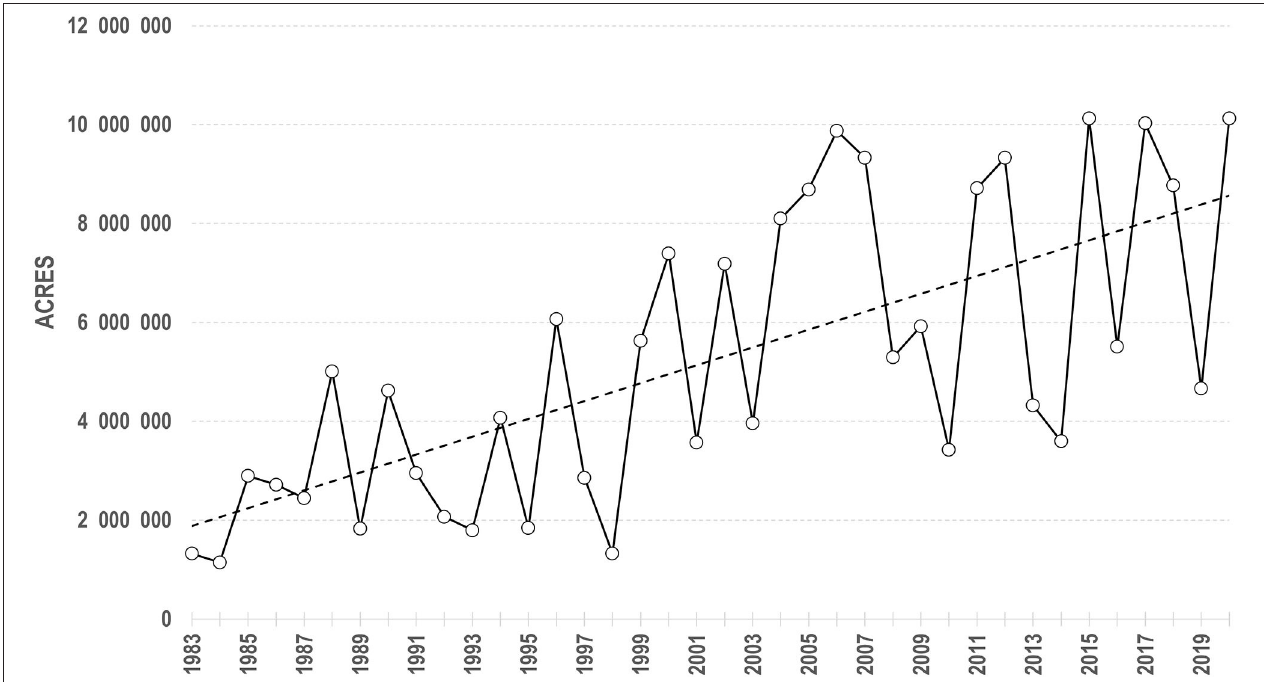
FIGURE 1 | Increasing trend of wildfires in the United States. The graph depicts the total area (in acres) affected by wildfires in the United States between the years 1983 and 2019. Data from the National Interagency Fire Center